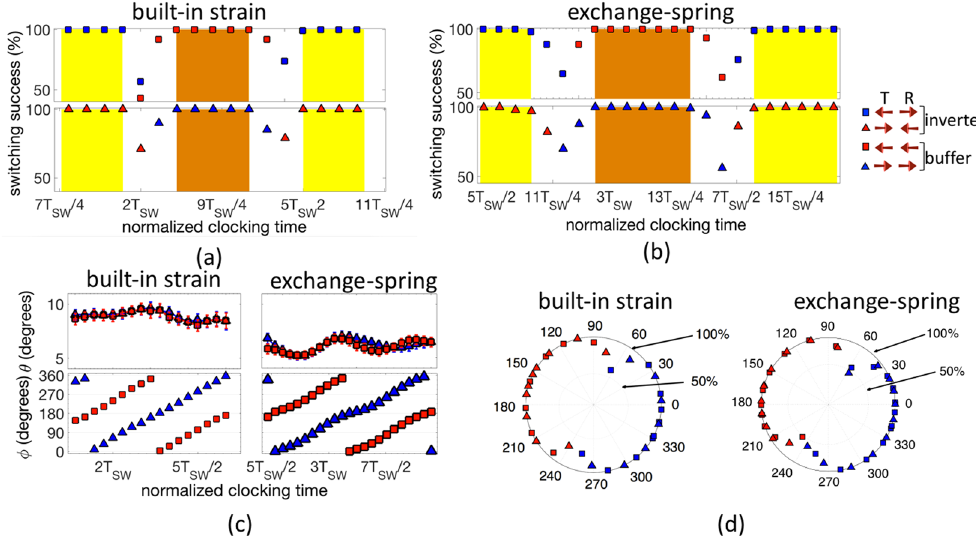
Figure 6. ( a , b ) Plot illustrating the impact of the time of clocking on the switching success for both the case of built-in strain and exchange-spring, respectively. In addition to a change in the logic function of the device from an inverter to a buffer, we also observe a switching margin in the range of T T /4 to /3 within which an error- SW SW free logic functionality can be ensured. ( c ) Detected amplitude ( θ ) and phase ( φ ) of the spin wave as function of the time of clocking. Note the error bars indicate the deviation ( σ φ ) from the mean value due to the presence of thermal noise. ( d ) Switching success as a function of the detected mean phase. An error-free logic functionality is achieved if the detected phase falls within the window from 280° through 0 to 20°, i.e. 100°, or from 100° to 200°.